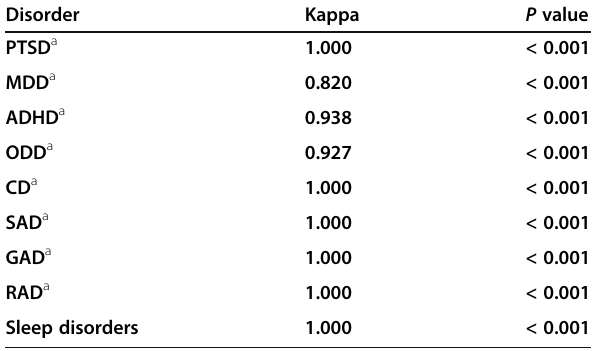
Table 3 Test-retest reliability for DIPA Disorder Kappa